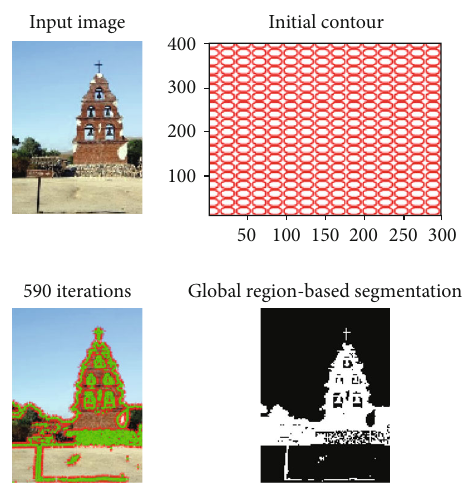
Figure 6: Result of the Chan-Vese algorithm.